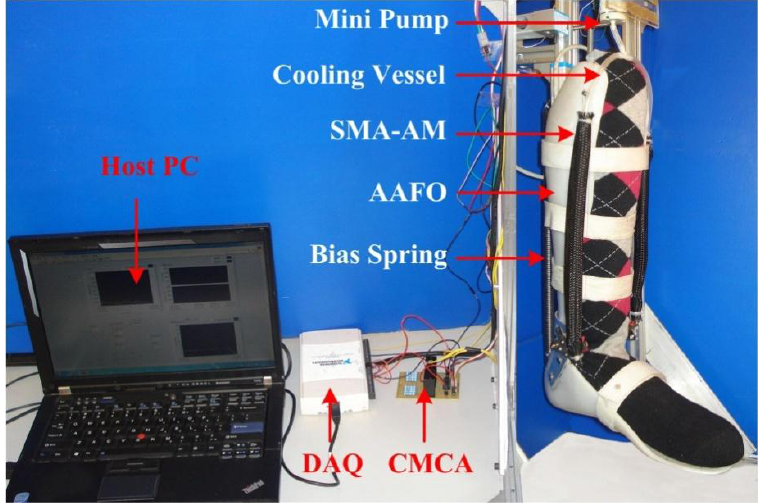
Figure 12. Artificial skeletal muscle actuated 1-DOF robotic